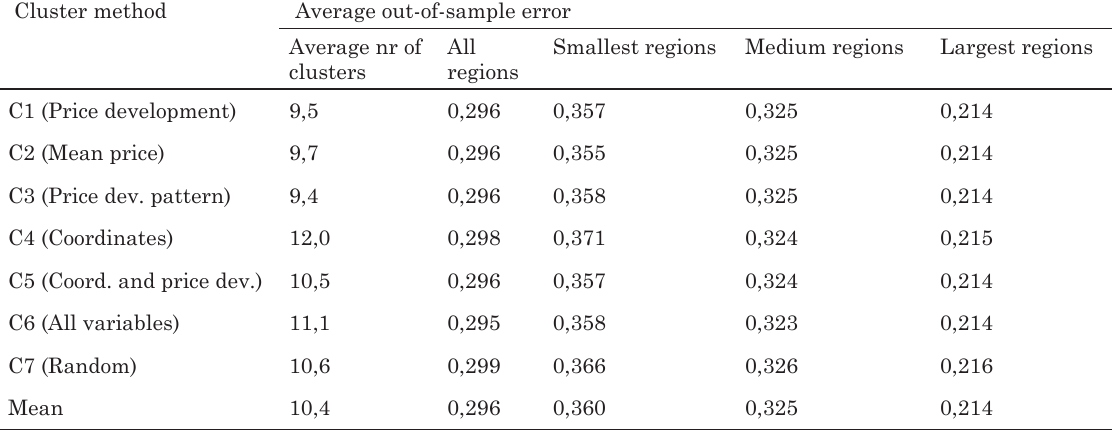
0,320,340,360,380,40,420,440,46 0,3 16111621263136414651566166717681869196101 Figure 6. Variation of RMSE between the replications for the clustering methods in the smallest regions